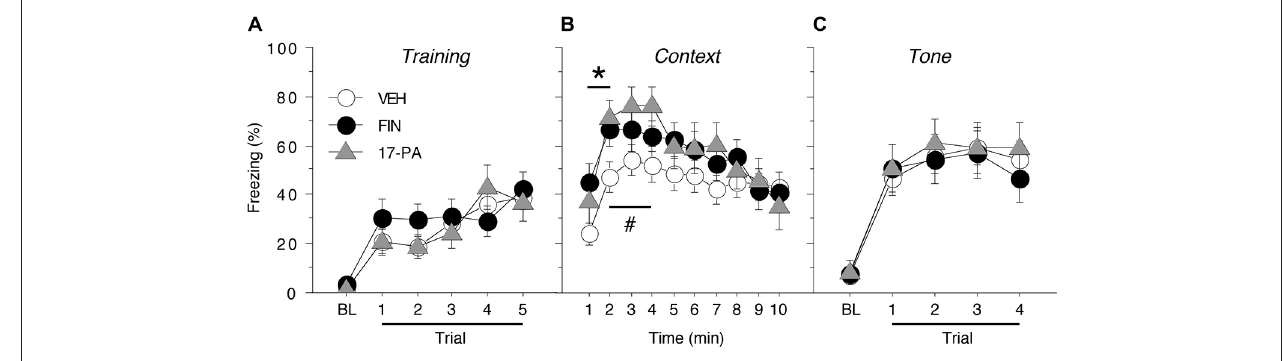
FIGURE 3 | Conditioned freezing in female rats receiving pre-test infusions of either FIN or 17-PA into the BNST. (A) Mean percentage of freezing ( ± SEM) for all females during the five-trial training session (data are shown with a 3-min pre-trial period followed by five tone-shock pairings). Freezing was quantified before the first conditioning trial (baseline, BL) and during the 1-min period after each conditioning trial.